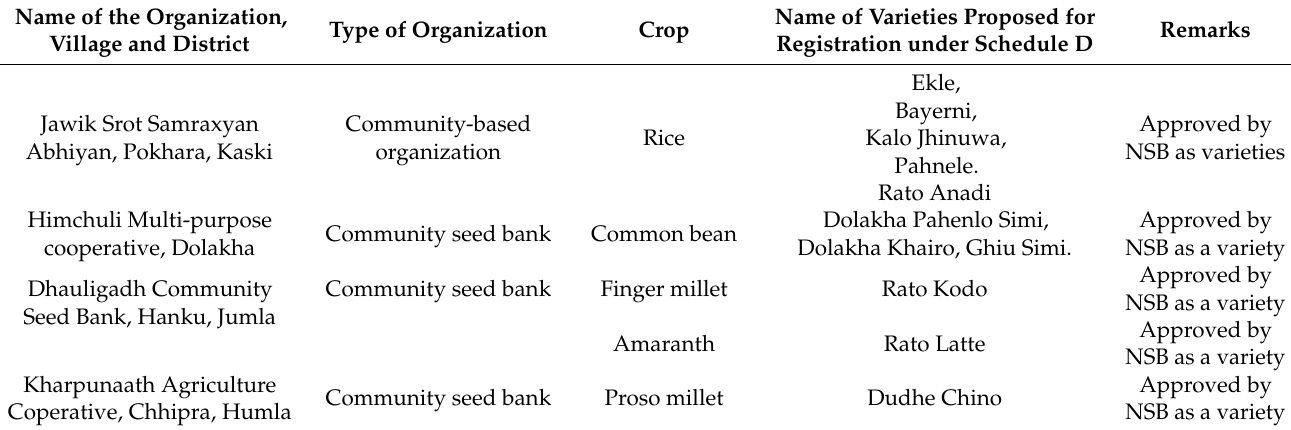
Table 2. Farmers’ varieties proposed for varietal registration under Schedule